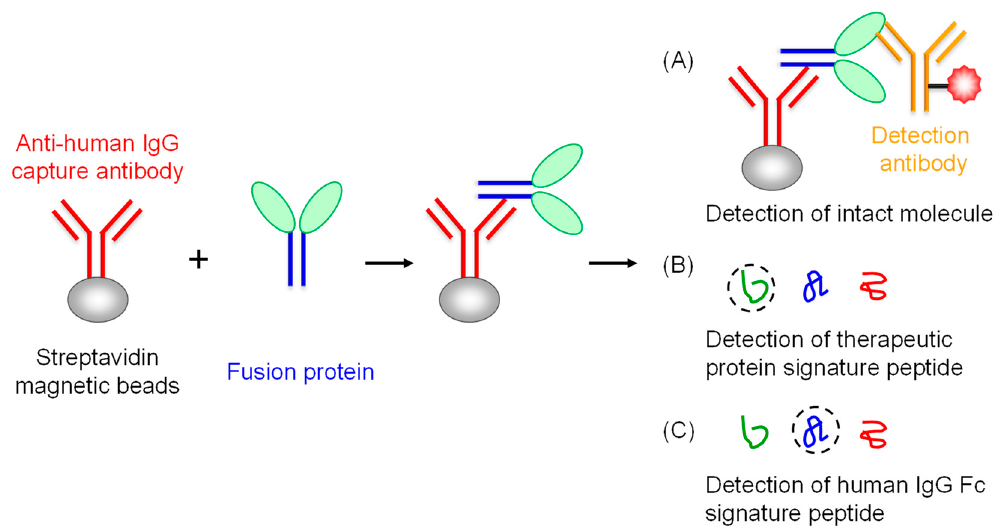
Figure 1. Ligand binding assay (LBA) and IC-LC / MS-based assays for the TFP. The LBA assay measures the concentration of the intact TFP with an anti-human IgG (h + l) for capture and the labeled anti-therapeutic protein antibody for detection ( A ). The IC-LC / MS assay determines the concentration of the intact TFP based on the signature peptide from the therapeutic protein ( B ) or human IgG Fc ( C ).